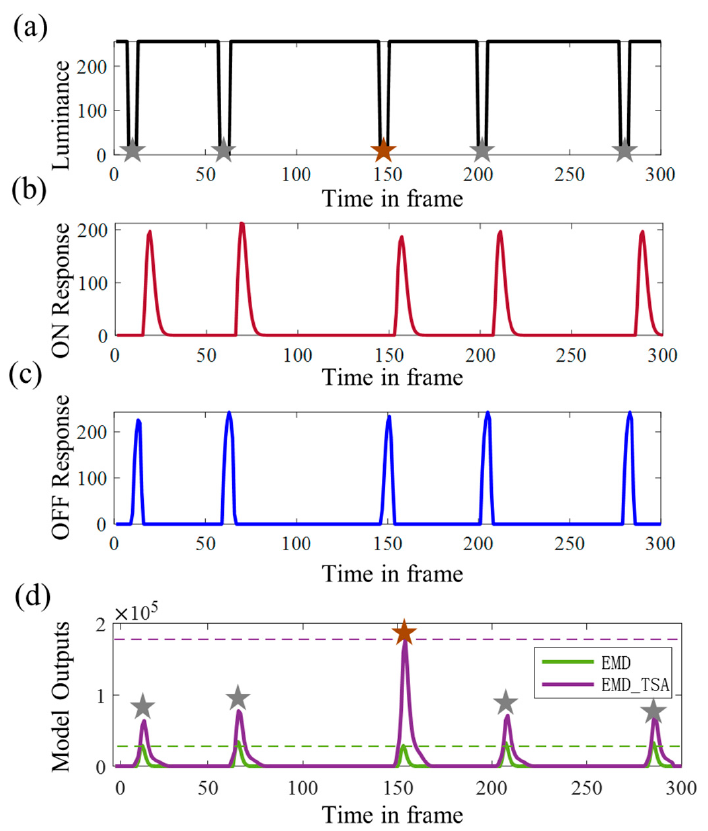
Figure 6. Outputs of various layers in the proposed model for moving target with flashed false targets in time. ( a ) The input luminance signal I ( x 0 , y 0 , t ) . ( b ) ON response S ON of the proposed model. ( c ) OFF response S OFF of the proposed model. ( d ) The outputs of EMD (green line) and EMD_TSA (purple line). The red asterisk marks the position of the moving target, and the gray asterisk marks the position of flashed false targets. The green dashed lines indicate the peaks of the EMD outputs, while the purple dashed lines correspond to the peaks of EMD_TSA outputs.